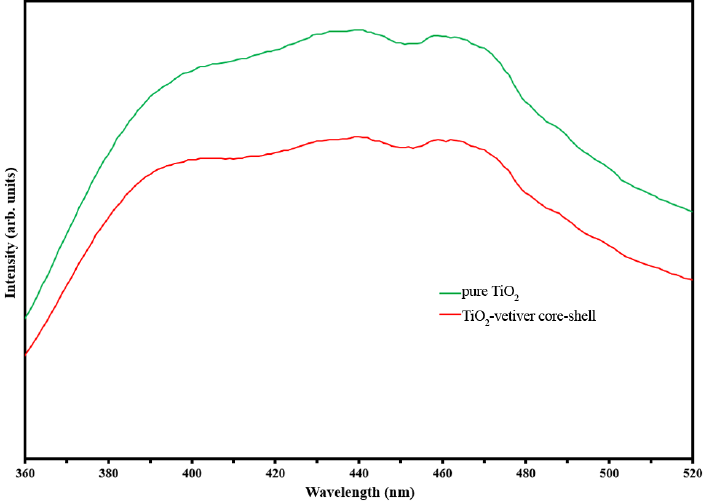
Figure 3. Photoluminescence (PL) spectra of pure TiO 2 and TiO 2 ‐ vetiver core–shell.